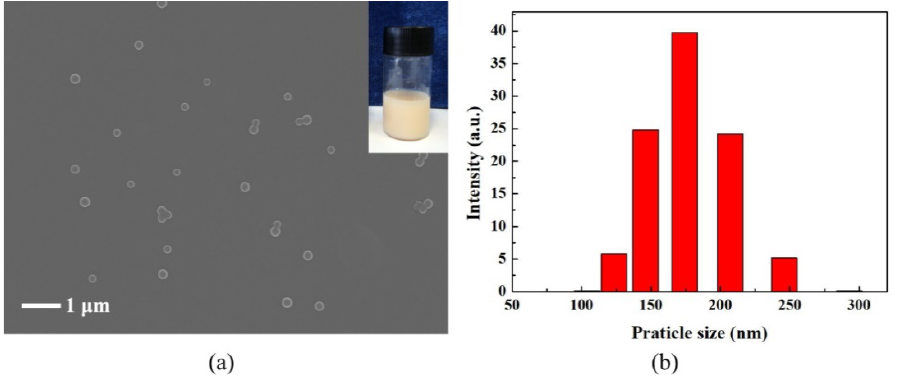
Figure 1. ( a ) SEM images and ( b ) size distribution curve of phenolic polymer (PP).